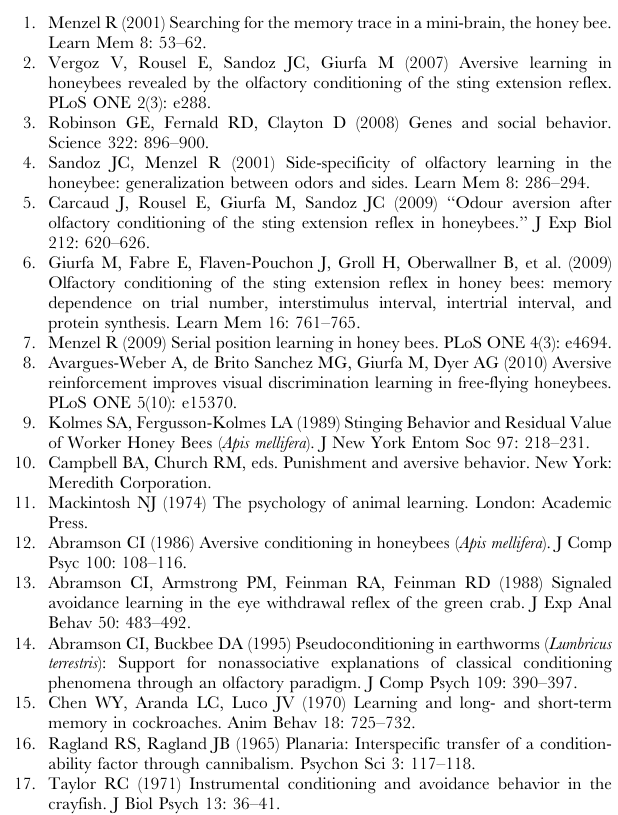
Figure S2 Genetic effects on variation in learning performance in the place preference assay. Experiments were performed with genetically similar bees obtained from a queen that was instrumentally inseminated by semen from a single drone ( SDI colony, genetic relatedness coefficient g =0.75) to see if the variations in learning were due to higher genetic variation found in typical colonies (typical colony, across colonies, g